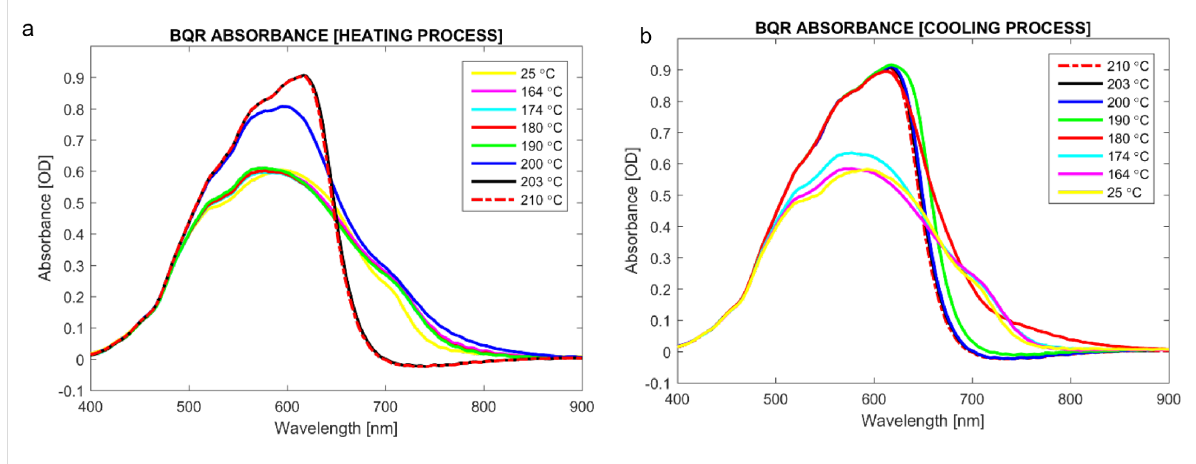
Figure 8: Variable temperature thin film UV–vis absorption profiles for BQR , collected using the transmission lamp of the POM and fibre-optic spec- trometer.